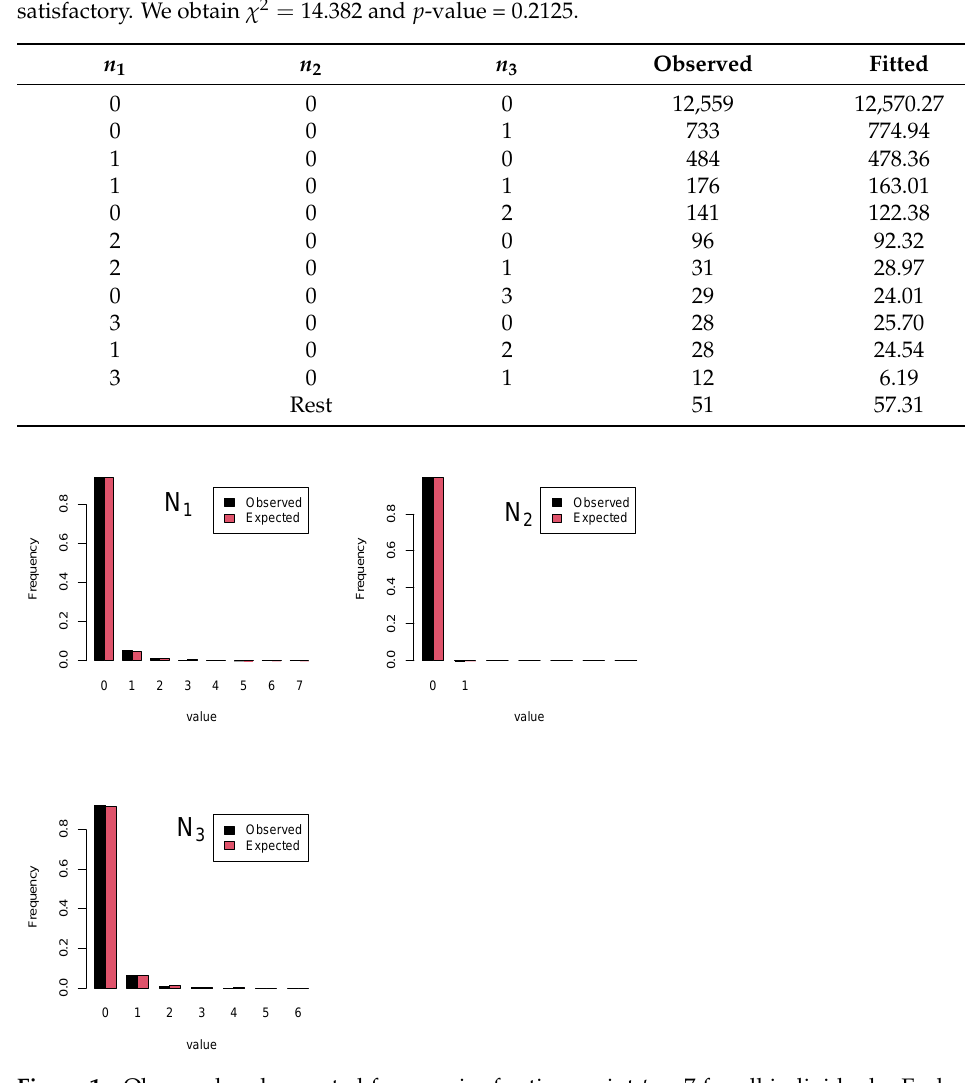
Figure 1. Observed and expected frequencies for time point t = 7 for all individuals. Each plot corresponds to one of the three